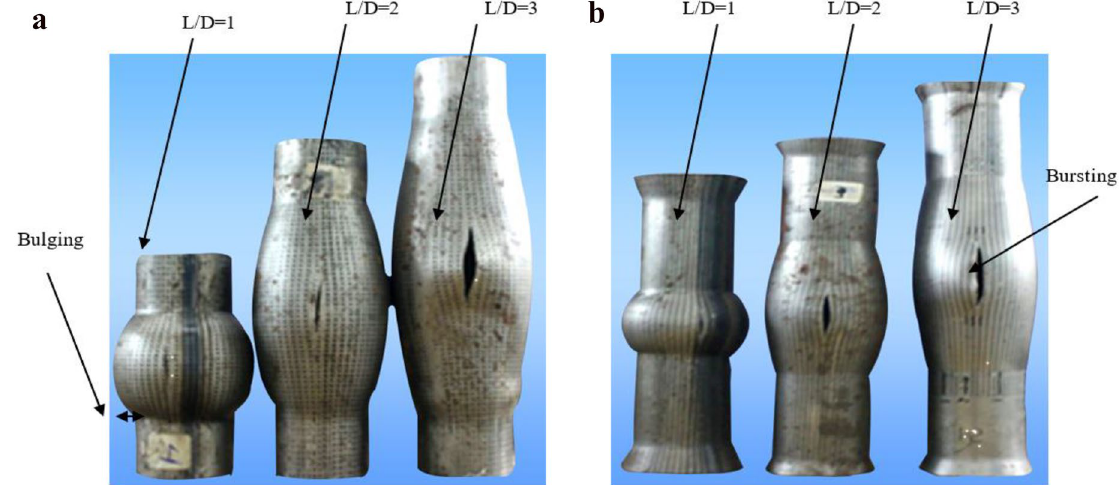
Fig. 8 Bulging of tubes of a axial, b fixed feed for